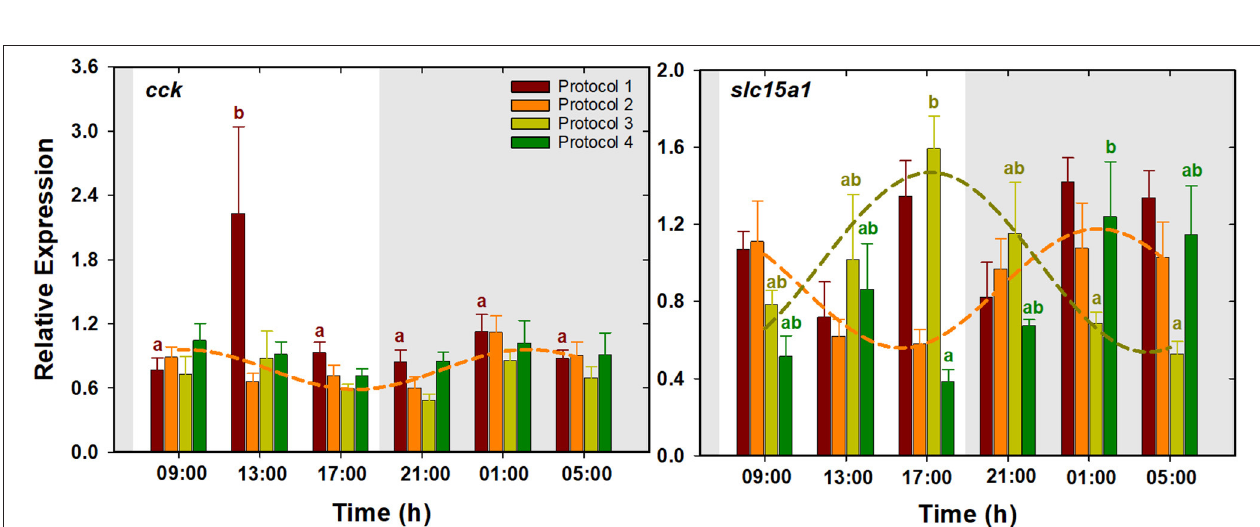
Frontiers in Marine Science |